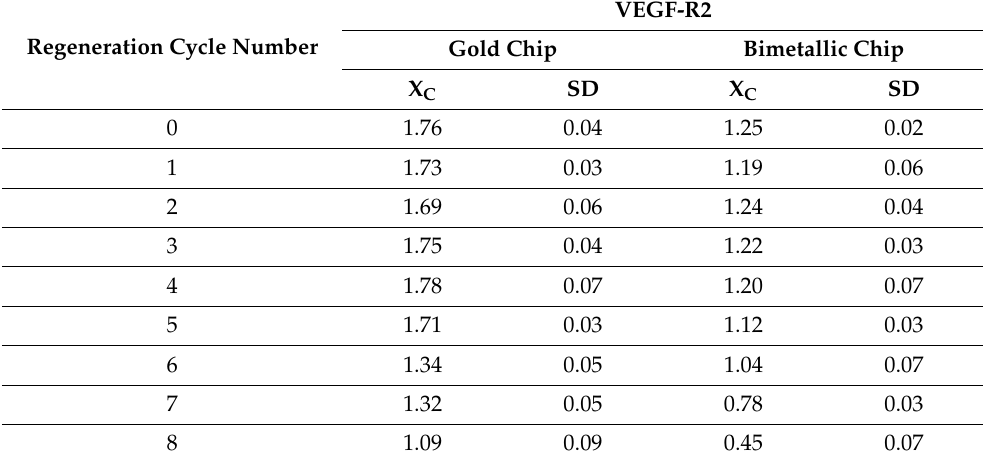
Table A2. Investigation of the influence of the number of regeneration cycles on